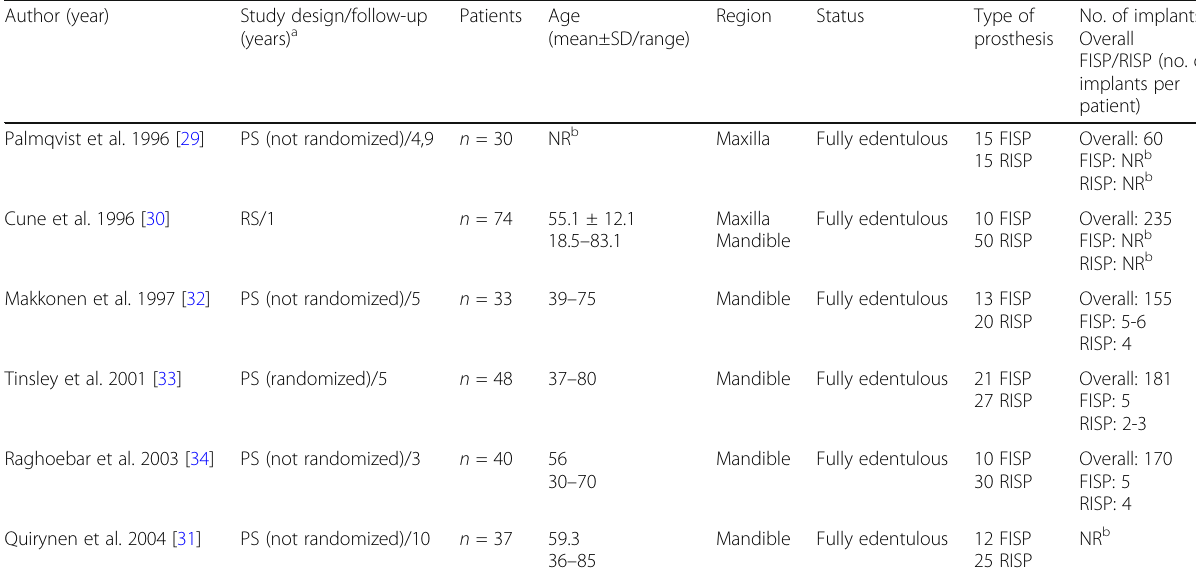
Table 5 Characteristics of studies included in this review Author (year) Study design/follow-up Patients (years) a